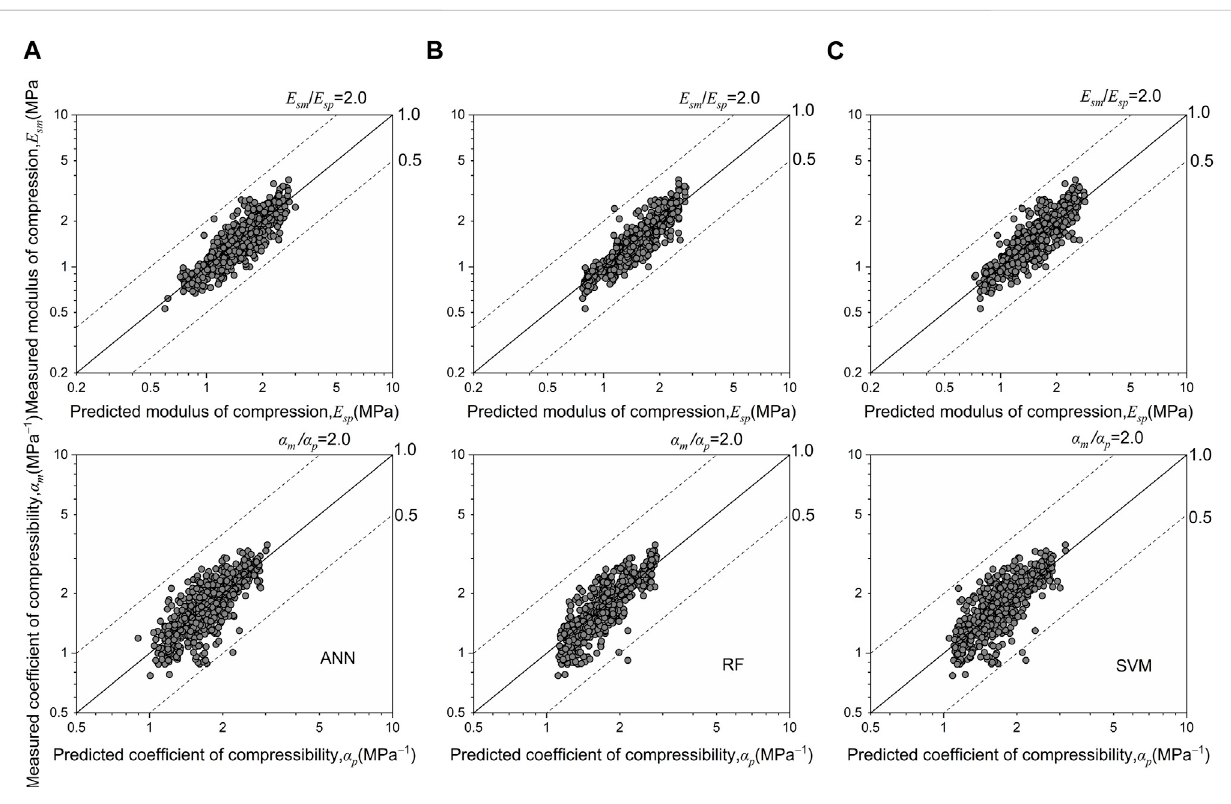
Measured compression indices versus values predicted by the trained ML models using all datasets: (A – C) E sm versus E sp and α m versus α p for the ANN, RF, and SVM models,